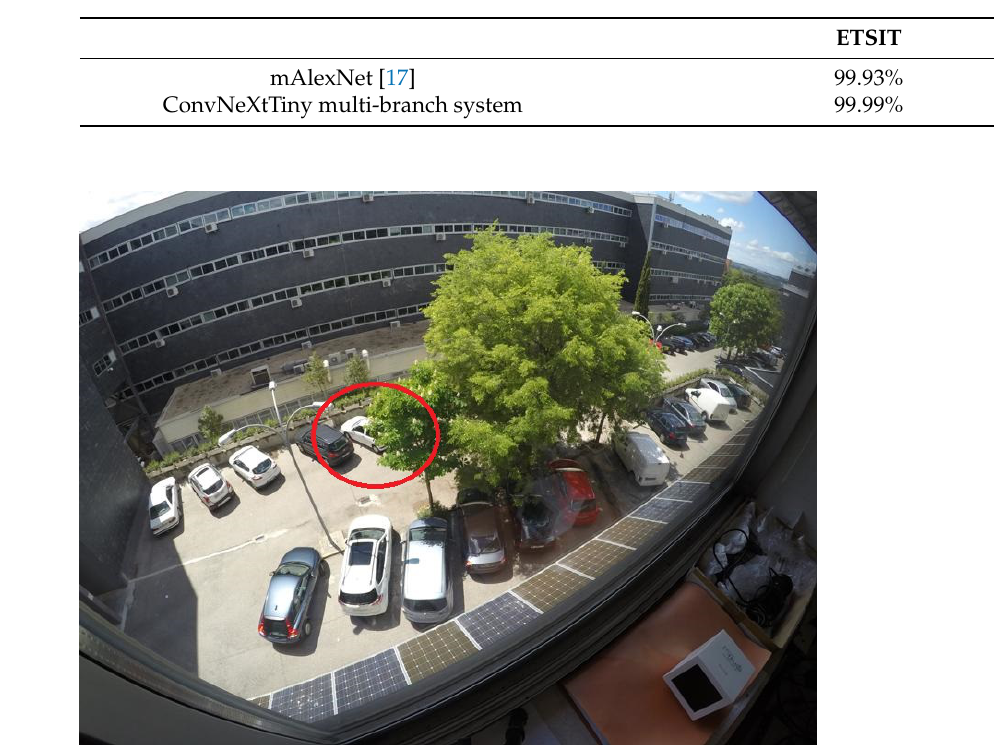
Figure 5. Example of a parking scenario of the ETSIT dataset with a partial occlusion given by a tree.